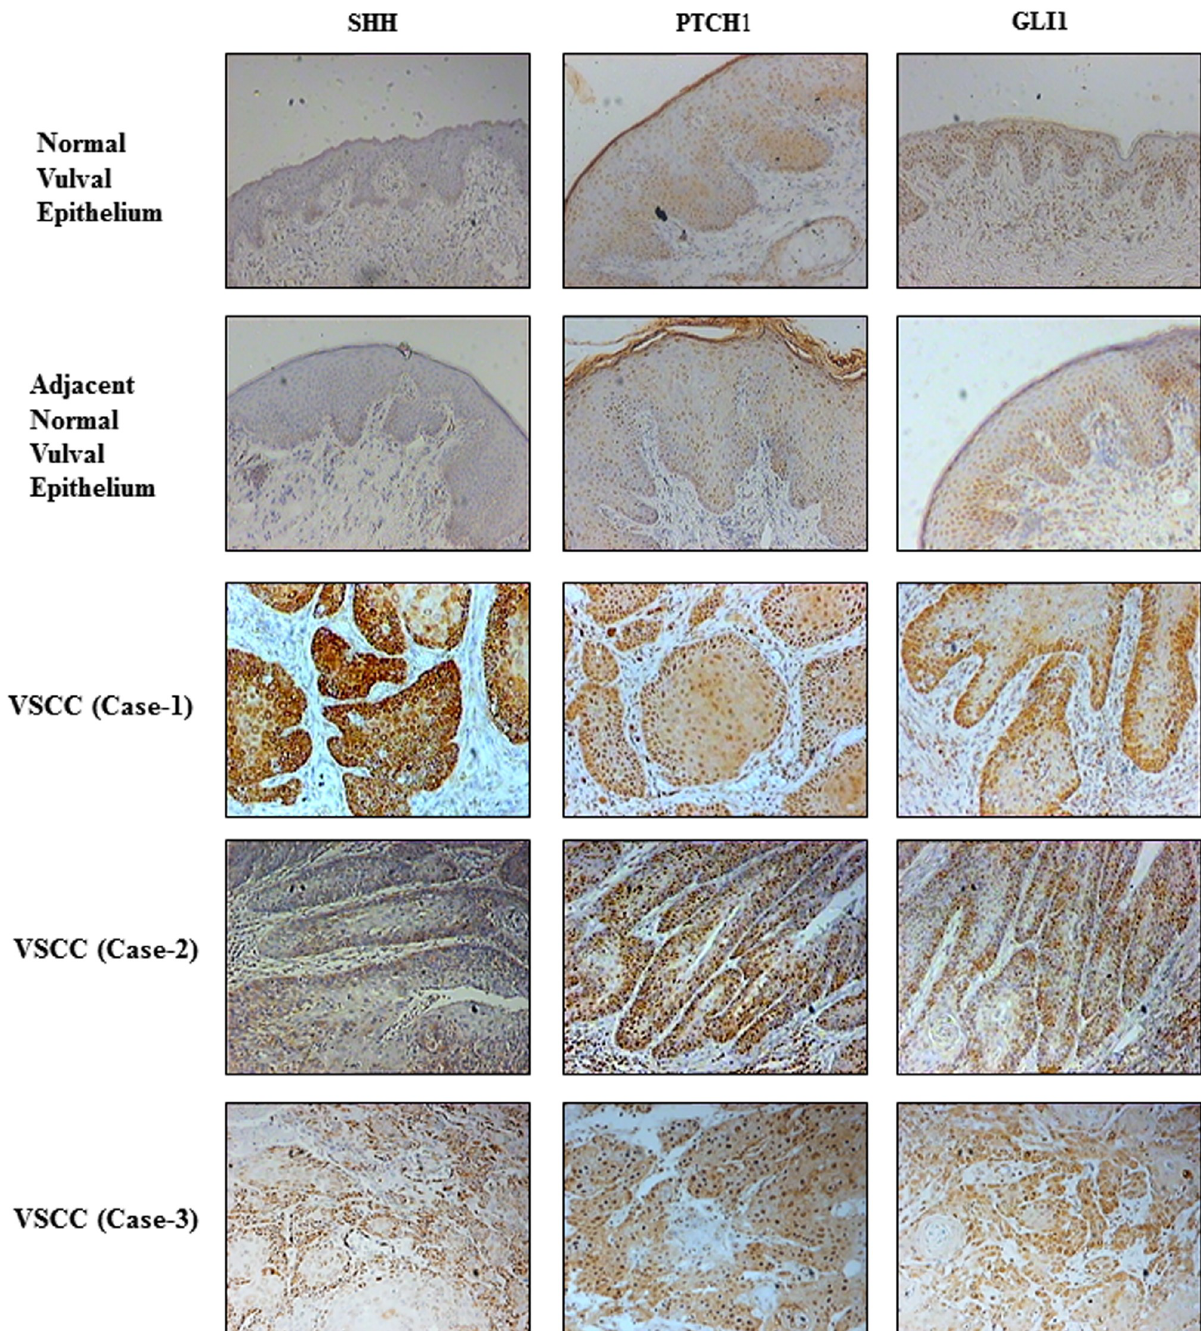
Fig 1. The Hedgehog pathway is aberrantly activated in VSCC compared to normal vulval epithelium. Representative immunohistochemical staining showing differential expression of SHH ligand, PTCH1, and GLI1, in normal vulval squamous epithelium, normal tumour-adjacent vulval epithelium (upper panels) and three primary VSCC cases (lower panels) (original magnification x200). Insets show higher magnification of the same sections (magnification x400).